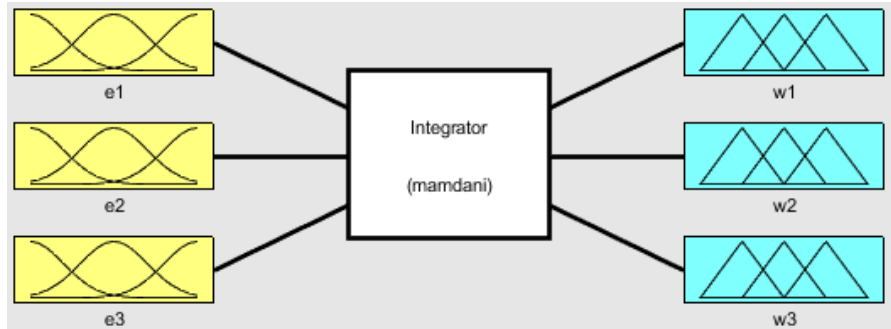
Figure 4. The structure of the fuzzy integrator with Gaussian membership functions.